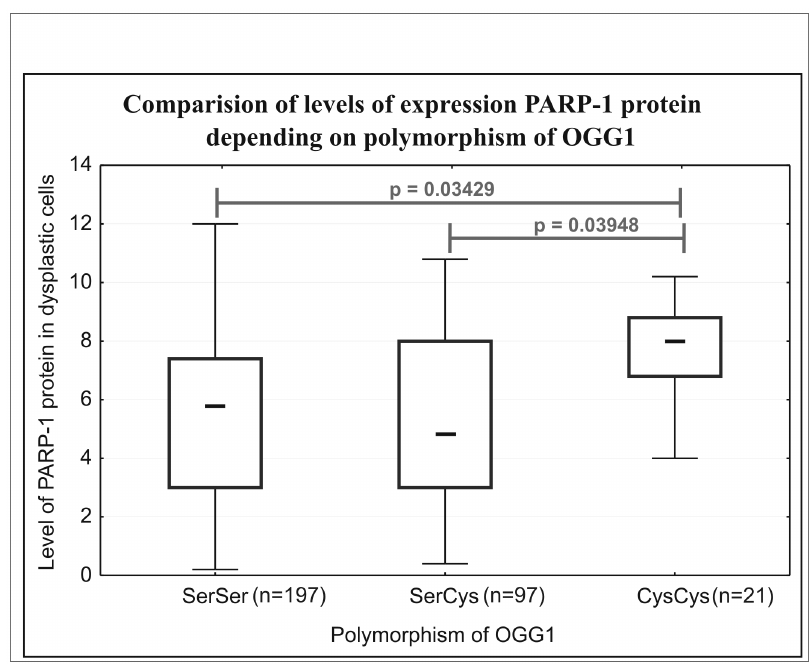
Fig. 5. Comparison of the level of PARP-1 protein expression in relation to OGG1polymorphism. Center mark in the box indicates medians for samples. The length of each box (IQR, interquartile range) represents the range within which the central 50% of the values fell, with the vertical edges placed at the first and third quartiles. Whiskers show variability outside the upper and lower quartiles. P was obtained with the Mann- Whitney